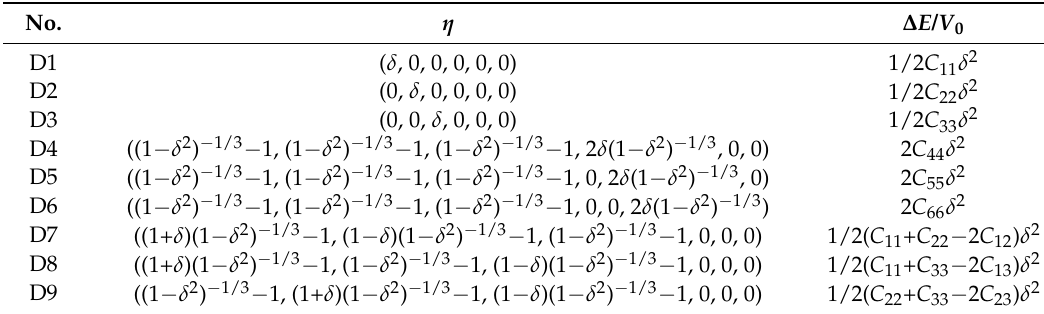
Table 1. Selected strains ( η ) and the corresponding strain energy densities ( ∆ E / V 0 ) for orthorhombic B19 TiAl